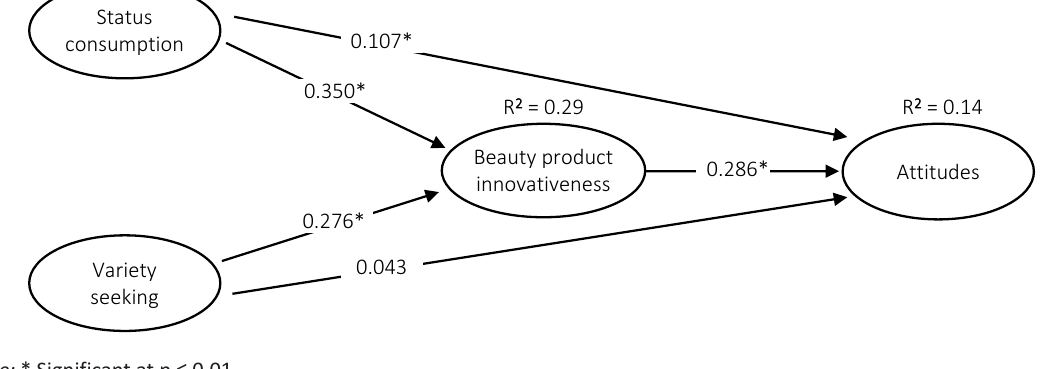
Figure 1. Structural